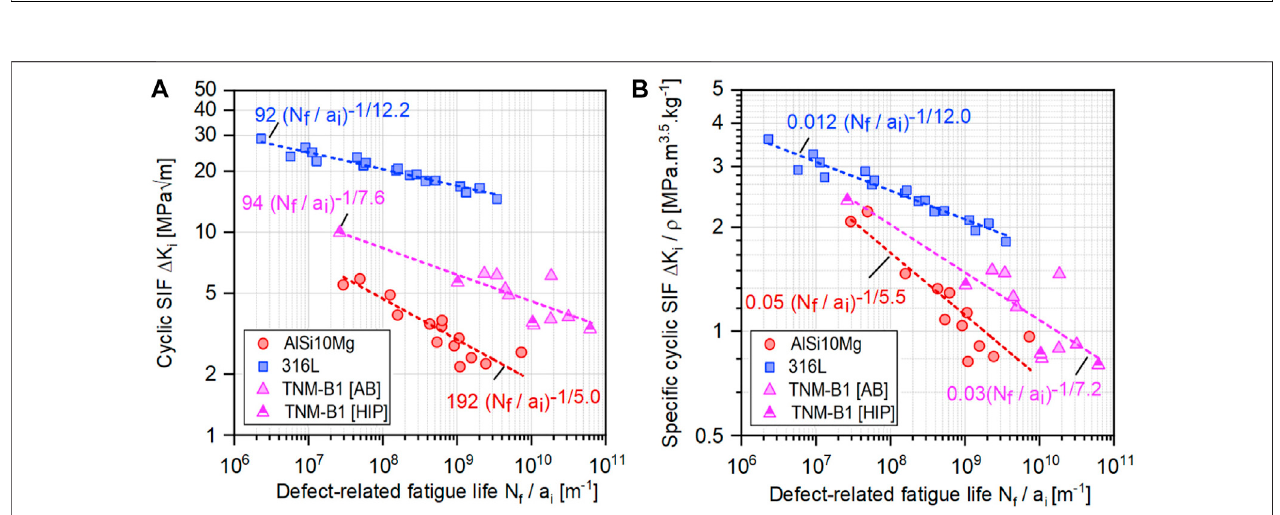
FIGURE3|(A) Shiozawadiagrams. (B) Speci fi cShiozawadiagramsforAlSi10Mg(Tenkampetal.,2022),316L(Kotzemetal.,2021;Sternetal.,2022),andTNM- B1 (Teschke et al., 2022)